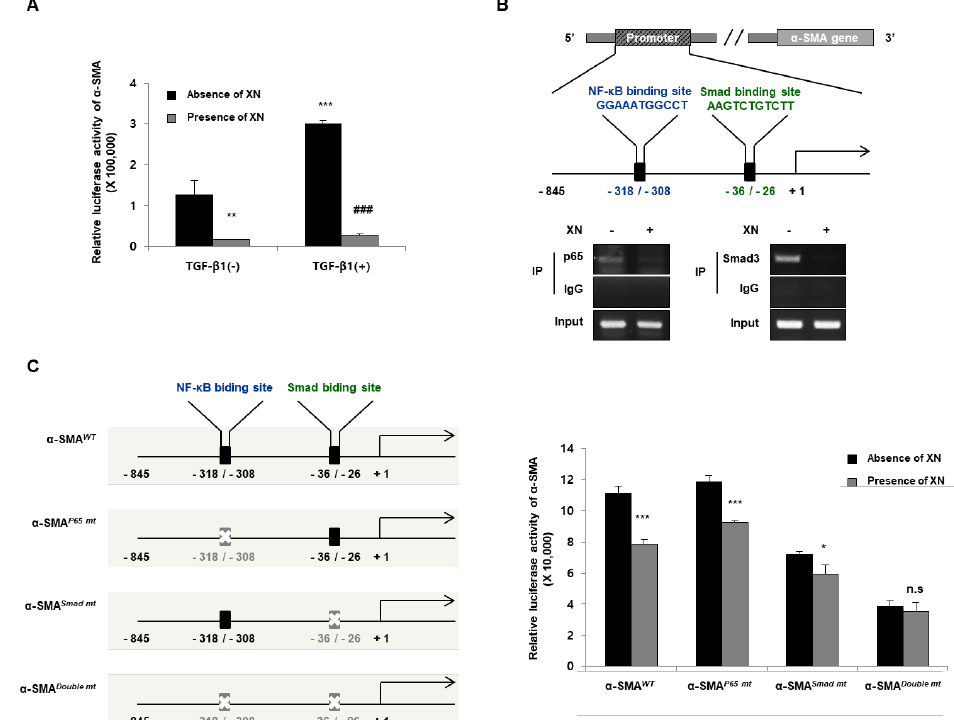
Figure 2. α -SMA transcriptional regulatory action of XN by reducing the expression of p65 and Smad3 in SW620 cells. ( A ) Reporter assay for α -SMA transcriptional activity. Data are means ± SD for three separate experimental samples. Data were analyzed by Tukey’s test (*** p < 0.001, ** p < 0.01 vs. vehicle cells; ### p < 0.001 vs. TGF- β1 treated cells). ( B ) ChIP assay using anti-p65, anti-Smad3, anti-Histone 3 (as a positive control), or anti-IgG antibody (as a negative control) and followed by PCR amplification using specific primers. ( C ) Illustration of luciferase reporters including NF- κB binding site and Smad binding site candidate regions in the α -SMA promoter sequence ( left ). Luciferase activity of α -SMA ( right ). Data are means ± SD for three separate experimental samples. Data were analyzed by Tukey’s test (*** p < 0.001, * p < 0.05 vs. absence of XN in all promoter construct-transfected cells).